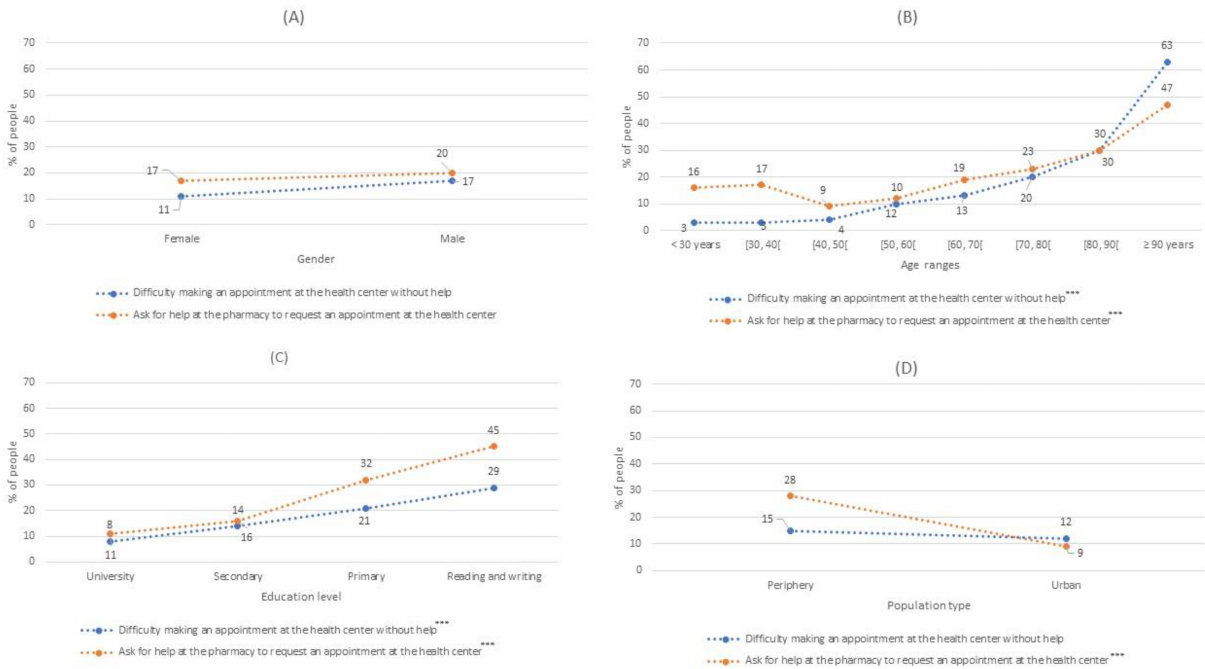
Figure 3. The percentages of people who had difficulty making an appointment at their health center without help or who received help at the pharmacy to make an appointment at their health center Modalities used to request an appointment al the health center by gender ( A ); by age ( B ), by educational level ( C ) and by population type ( D ). ***: p -value <